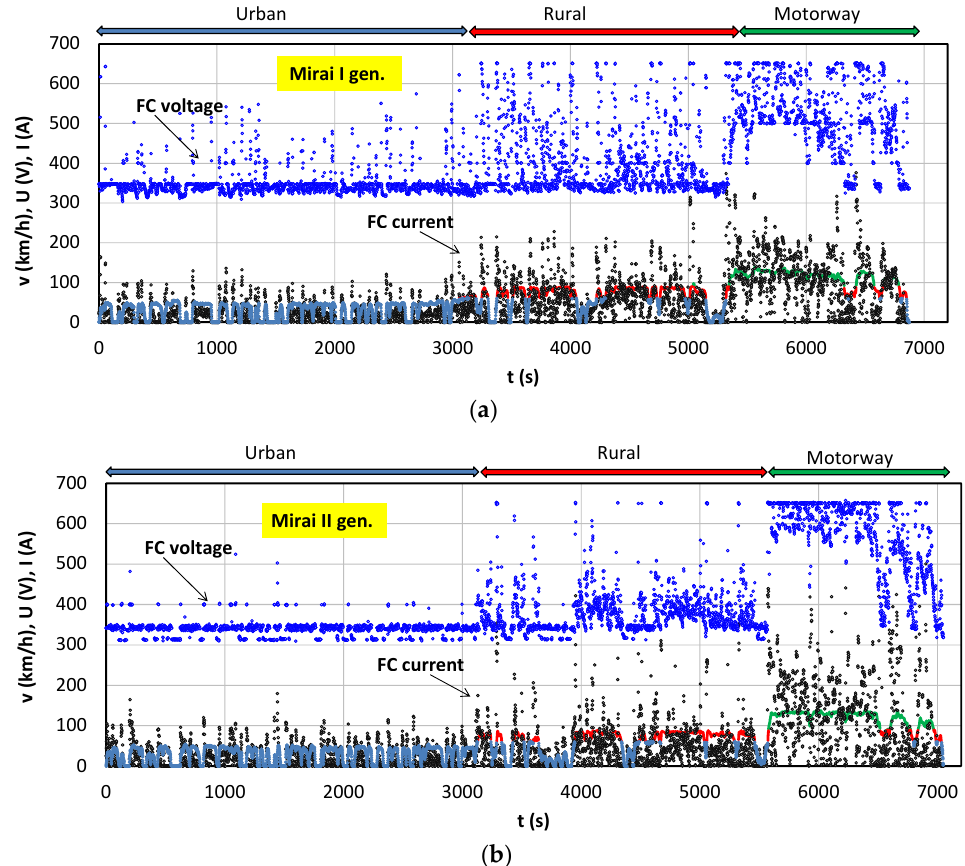
Figure 11. Voltage and current characteristics of the fuel cell converter depending on the speed profile: ( a ) first-generation FC; ( b ) second-generation FC.